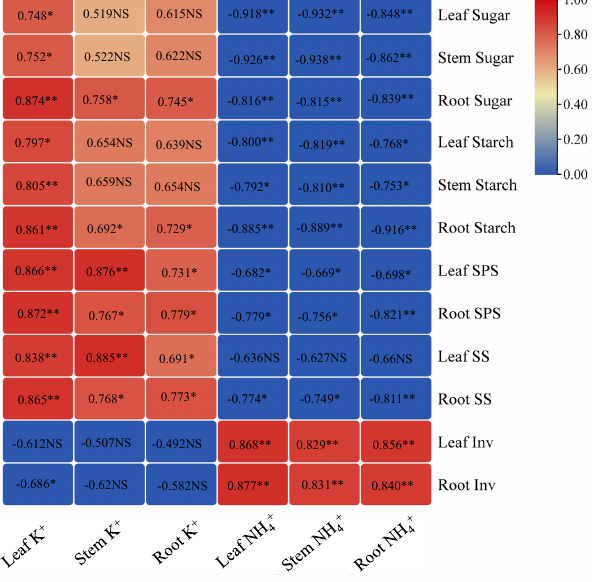
Figure 3. Relationship between sugar-related parameters and ion content (NH 4+ and K + ) of tobacco leaves, stems, and roots. The numbers in the figure represents the coefficient of determination, R 2 . The minus sign depicts a negative correlation between two indicators. * and ** demonstrate a posi- tive relationship between the indicators and a significant difference at p < 0.05 and p < 0.01, respec- tively. “NS” represents not significant. The data employed in the correlation analysis represent the mean value under each treatment ( n = 9).